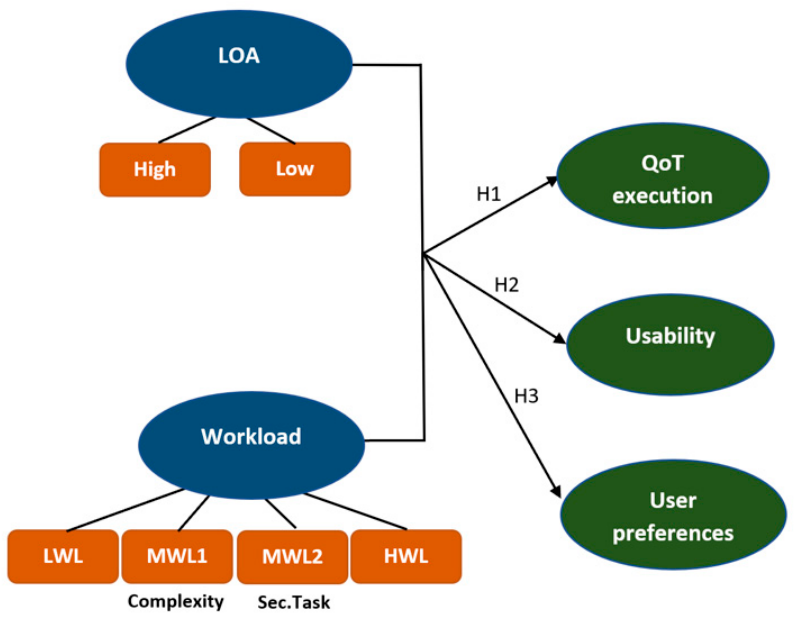
Figure 5. Model for the study and hypotheses.